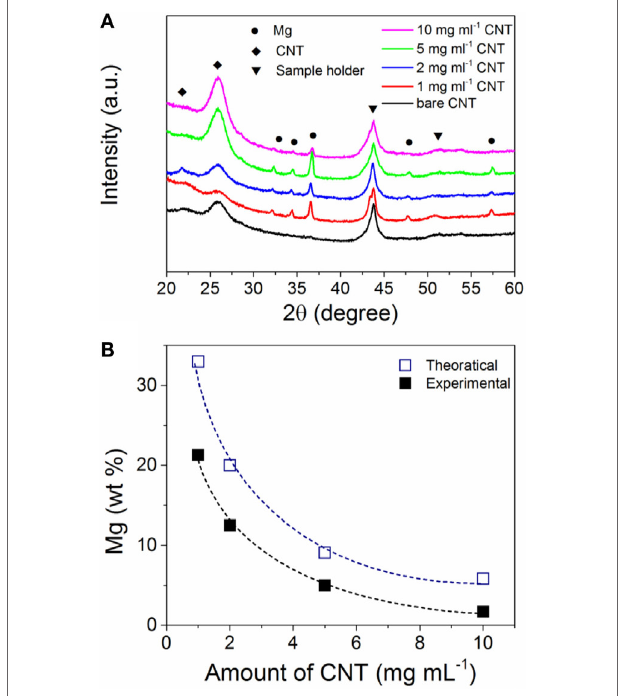
FigUre 1 | (a) X-ray diffraction (XRD) patterns of bare carbon nanotubes (CNTs) and electrochemically magnesium (Mg) deposited on CNTs with different amounts in the electrolyte; (B) amount of magnesium (Mg) in the Mg/CNTs composites as function of the amount of CNTs in the electrolyte. The theoretical amount of Mg deposited was calculated from the Faraday’s law by considering a 2-electron reduction